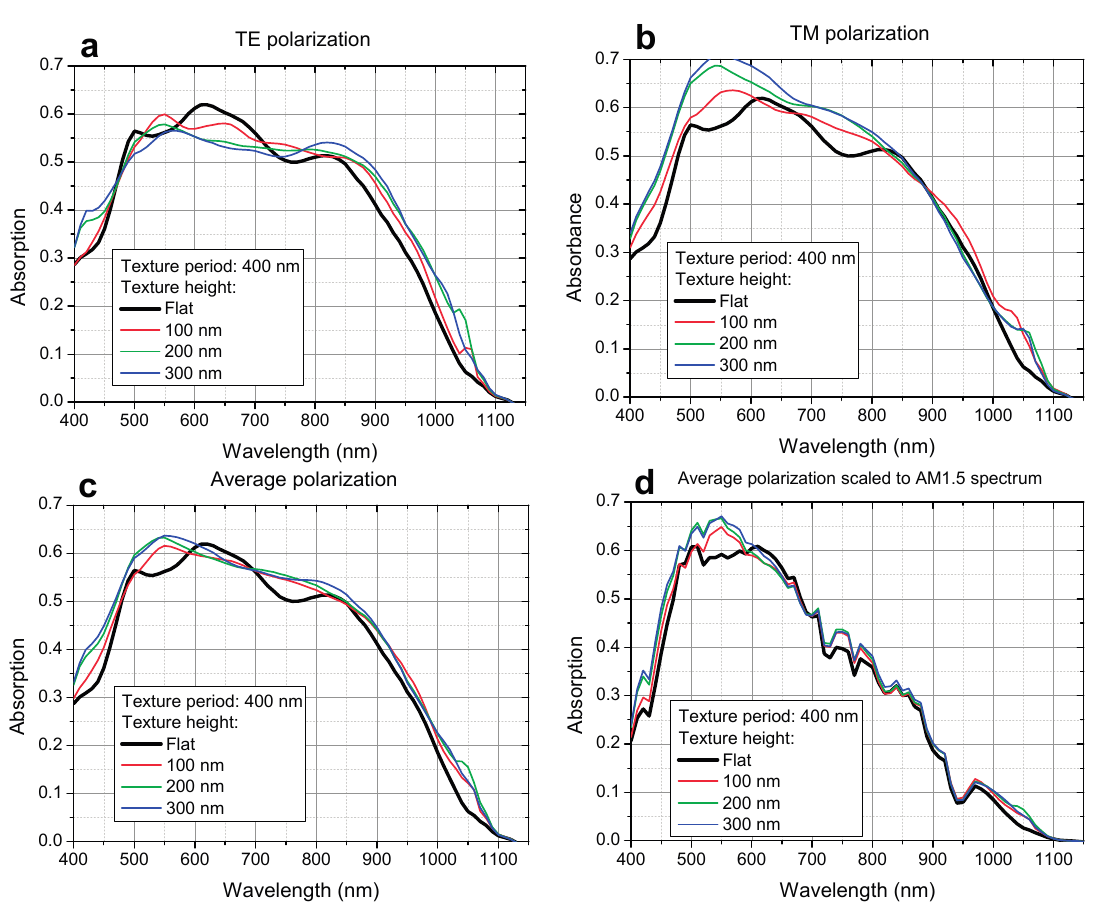
Figure 3. Absorption of the CIGS absorber layer with the use of triangular structuring, with texture period of 400 nm and variable height. ( a ) transverse-electric (TE) polarization; ( b ) transverse-magnetic (TM) polarization; ( c ) average polarization; ( d ) average polarization scaled to AM1.5 solar irradiance